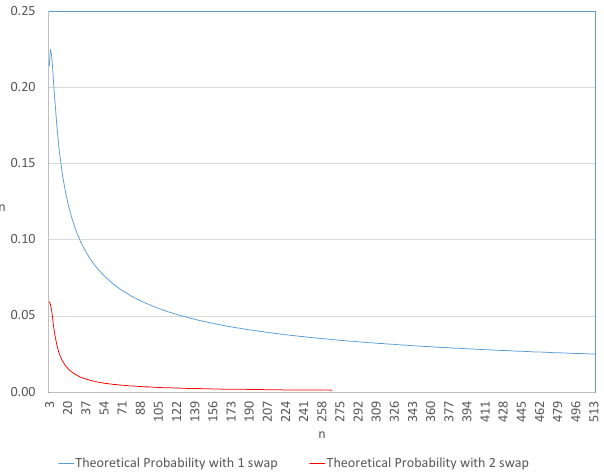
Figure 9. Comparison between the theoretical probabilities P 2 n (two swaps, in red) of Proposition 3 and the theoretical probabilities P 1 n (one swap, in blue) of Proposition 1, when increasing n ( X -axis).